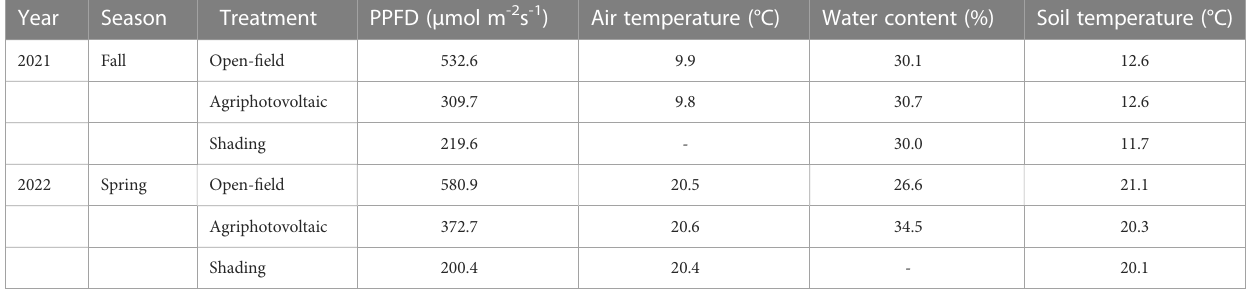
TABLE 1 The mean microclimate data comparing the three growth